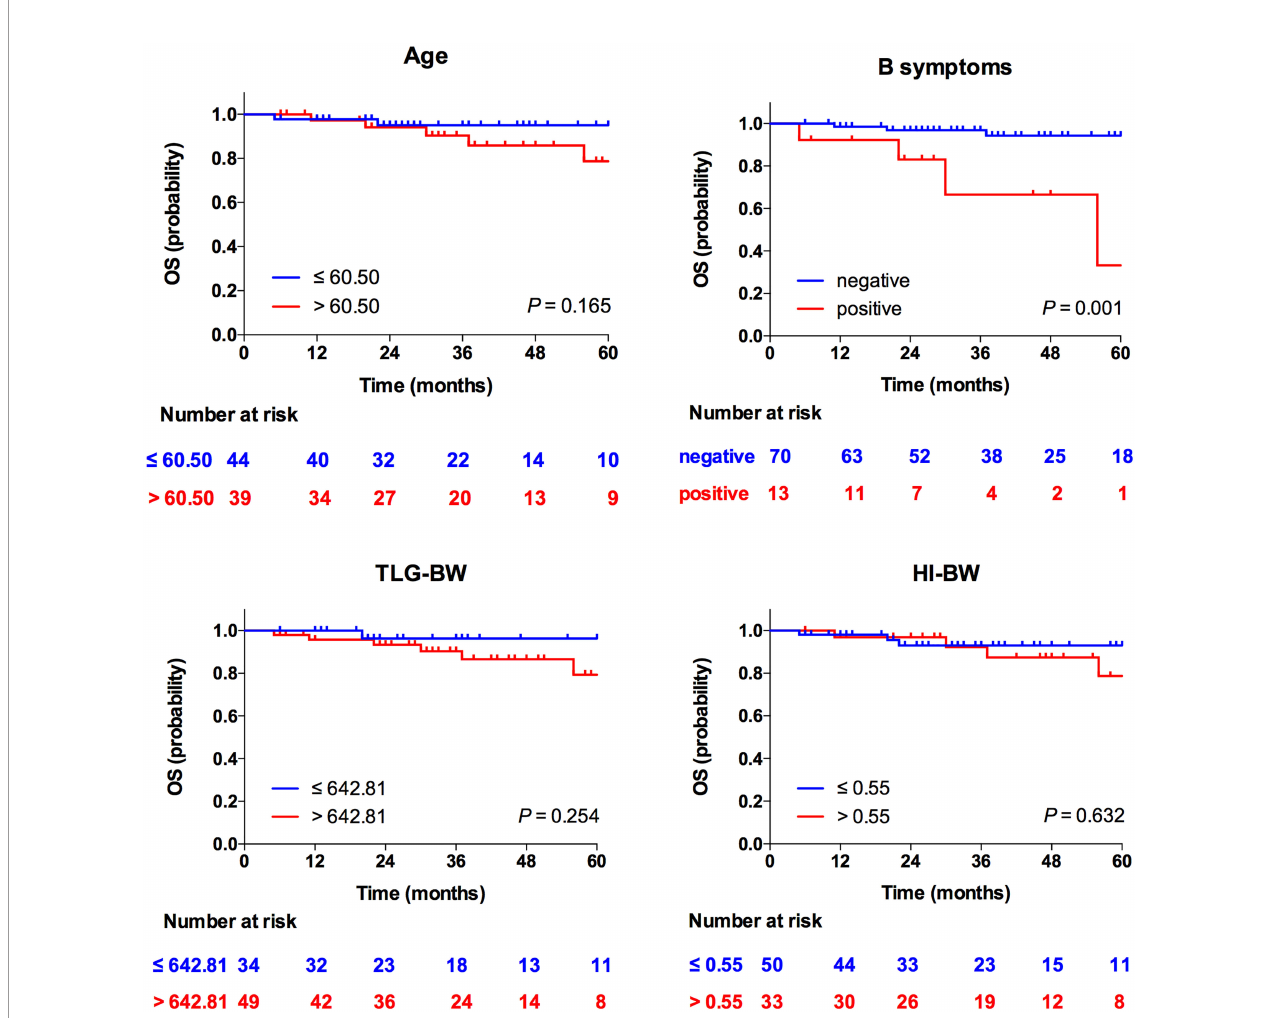
FIGURE 3 | Kaplan – Meier curves for OS according to age, B symptoms, TLG-BW, and